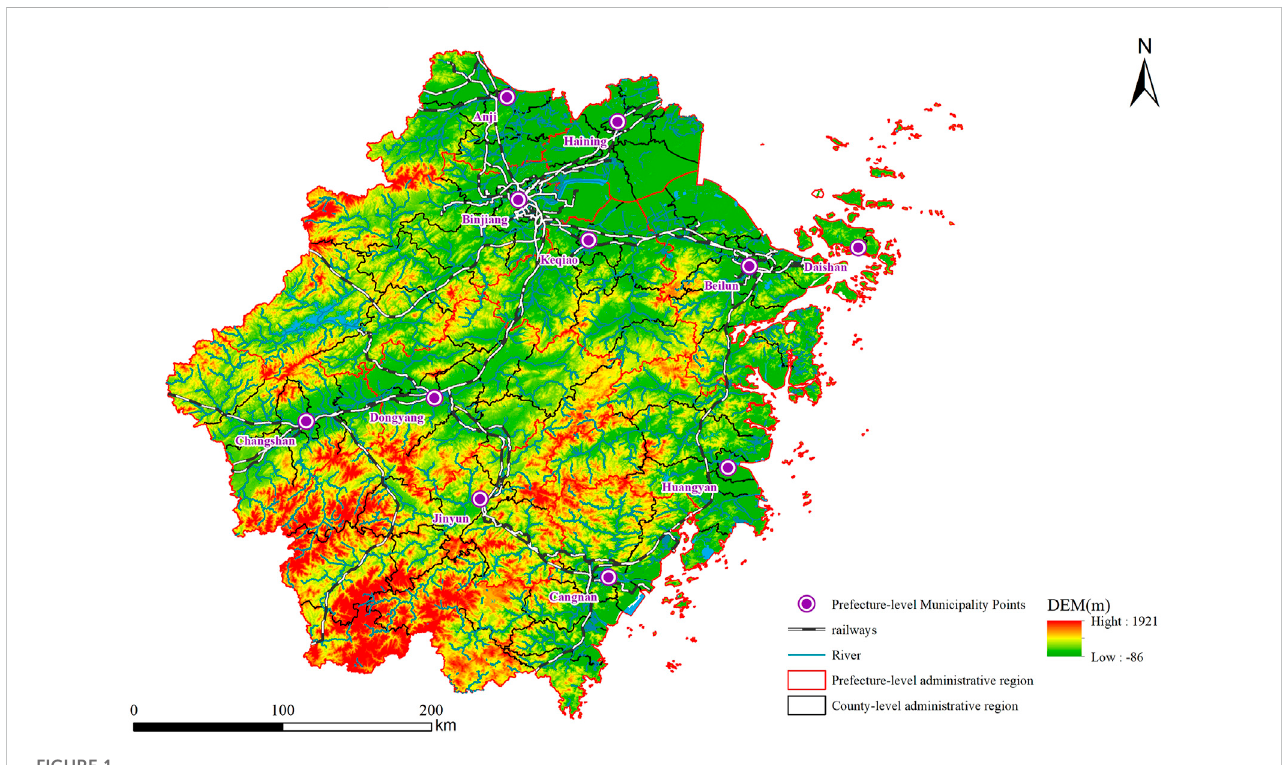
FIGURE 1 The map and overview of Zhejiang